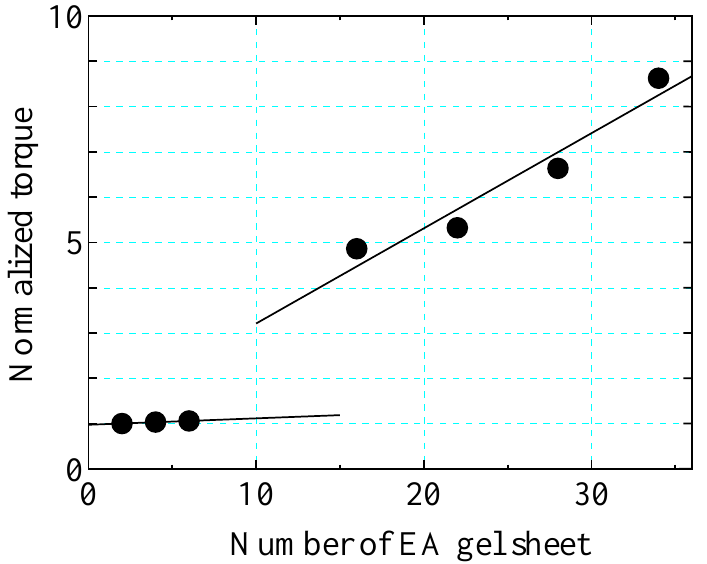
Figure 8. Comparing torques for different numbers of EA gel